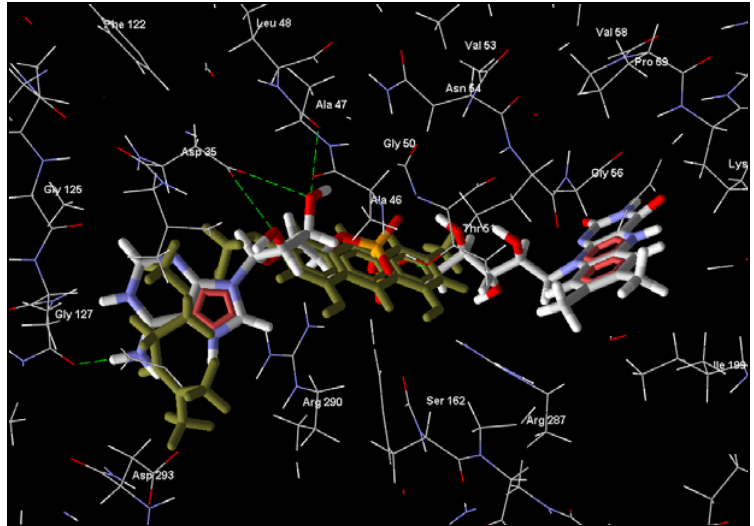
Figure 6. 3-Geranylemodin (brown) and FAD (white, red and blue) interacting with residues at the FAD binding site of TR. Hydrogen bonding interactions are shown as green dashed